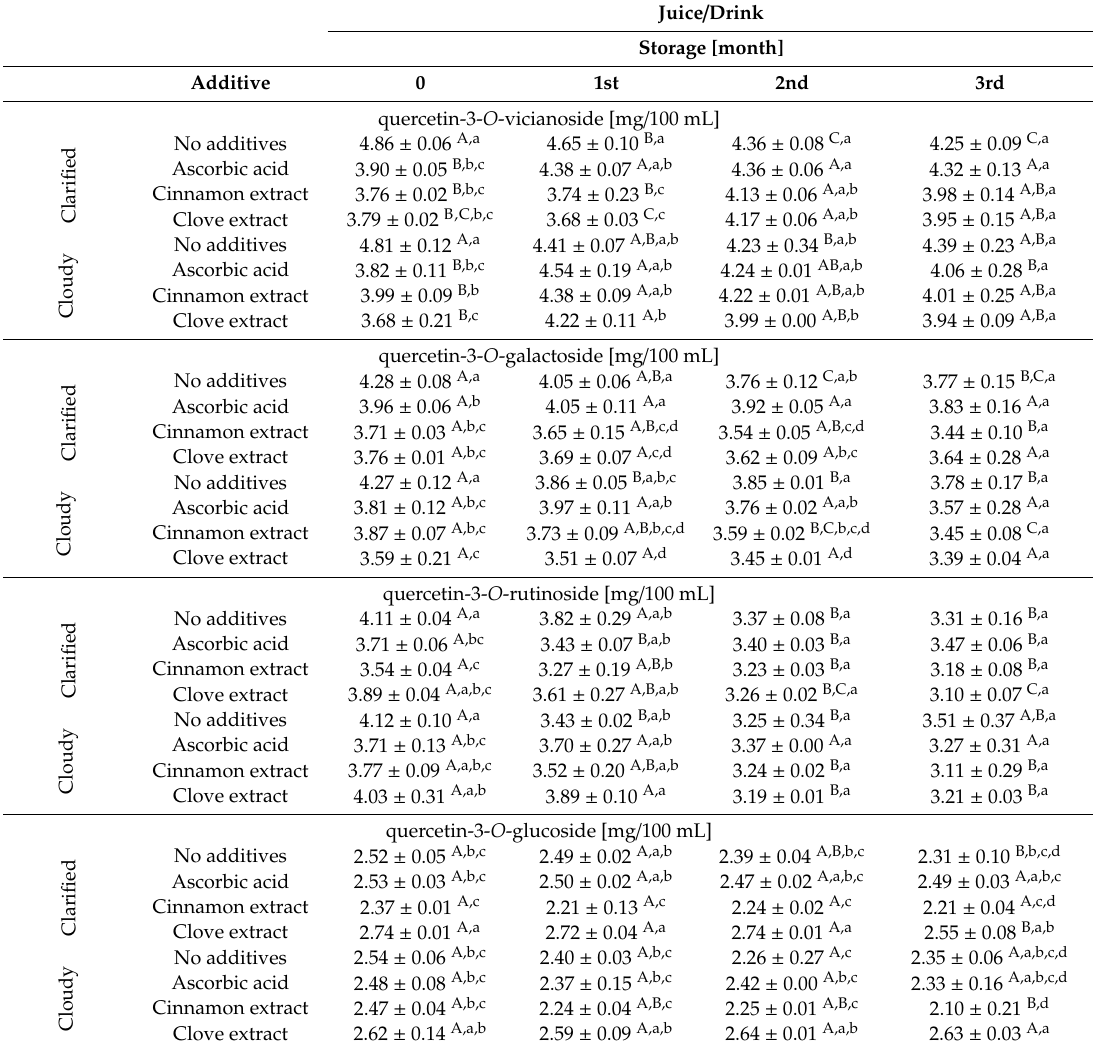
Table 5. Changes in flavonol content during storage of tested juices / drinks.